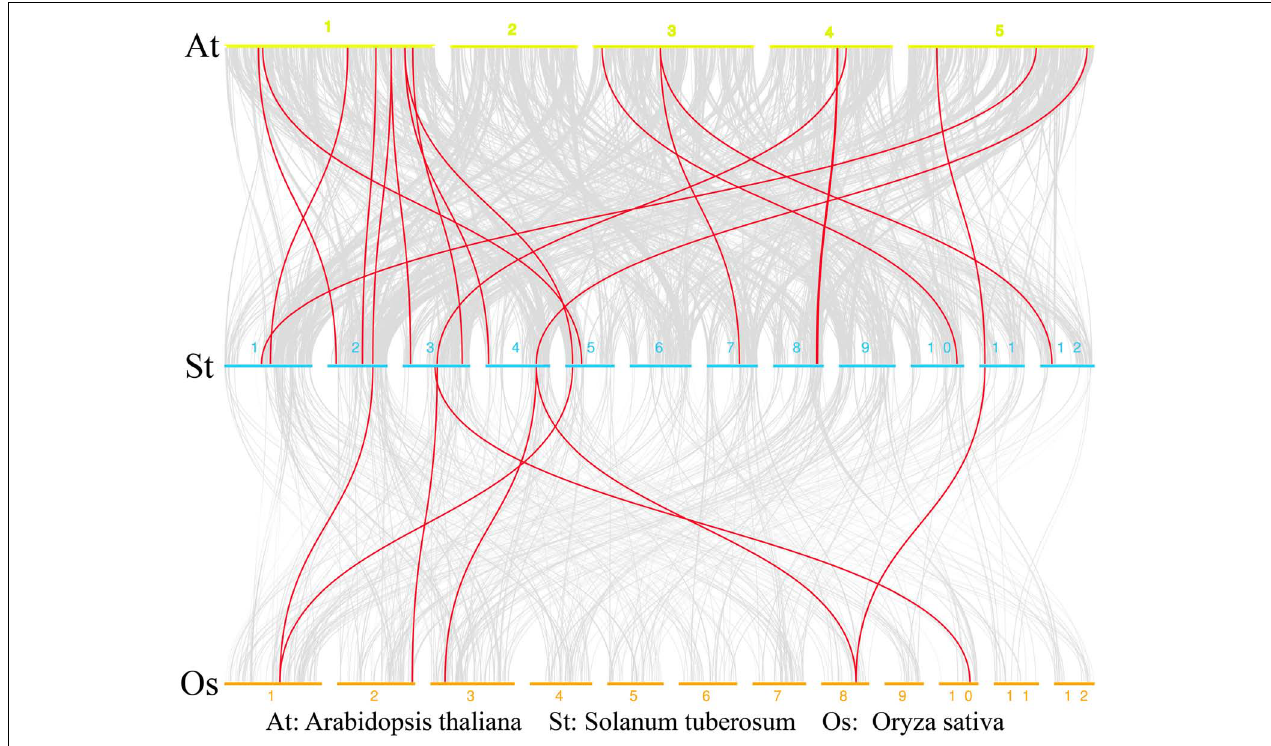
FIGURE 3 | Collinearity analysis of multidrug and toxic compound extrusion (MATE) genes in rice, potato, and Arabidopsis . Chromosomes of Arabidopsis , potato, and rice are represented by yellow, blue, and orange bars, respectively; the chromosome label is next to the corresponding chromosome. The red curve indicates MATE genes with